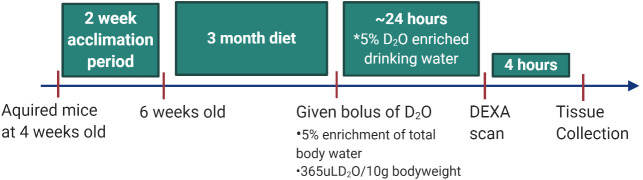
Timeline of study.